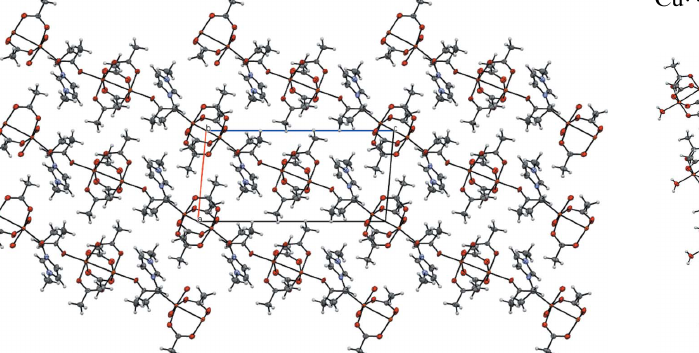
distances in such fragments is shown in Fig. 9. From a comparison of Fig. 9 and Table 1, it can be seen that the